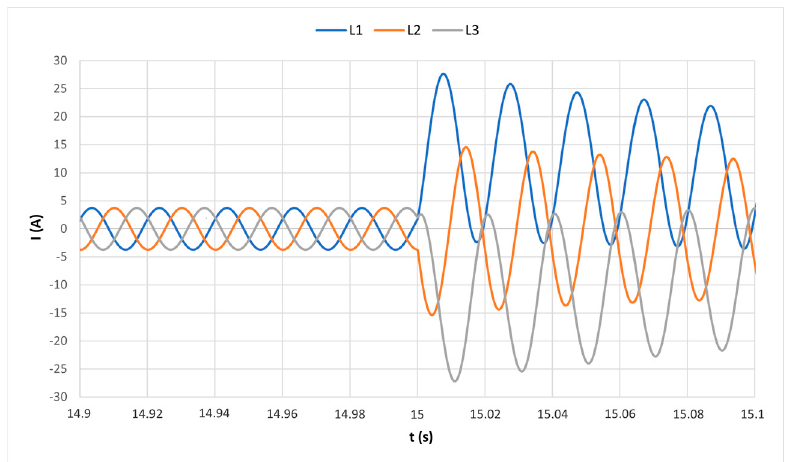
Figure 17. Simulated values of diesel generator model currents during a 3-Ph ground fault condition at the source.